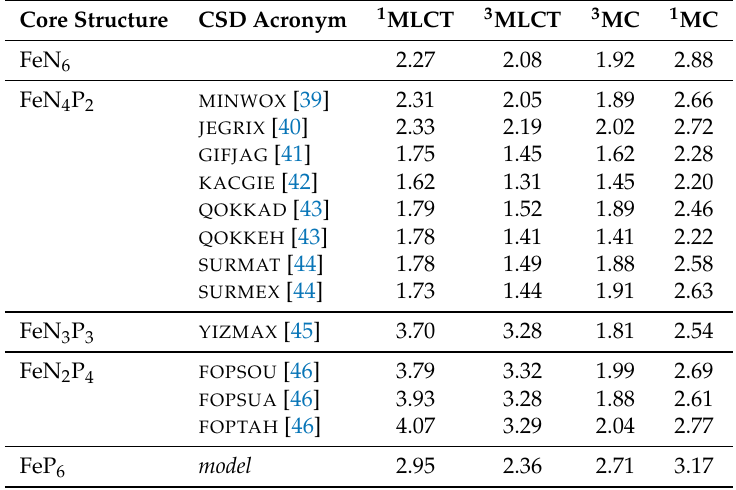
Table 2. Vertical excitation energies for a series of FeN ( 6 − x ) P x complexes. Core